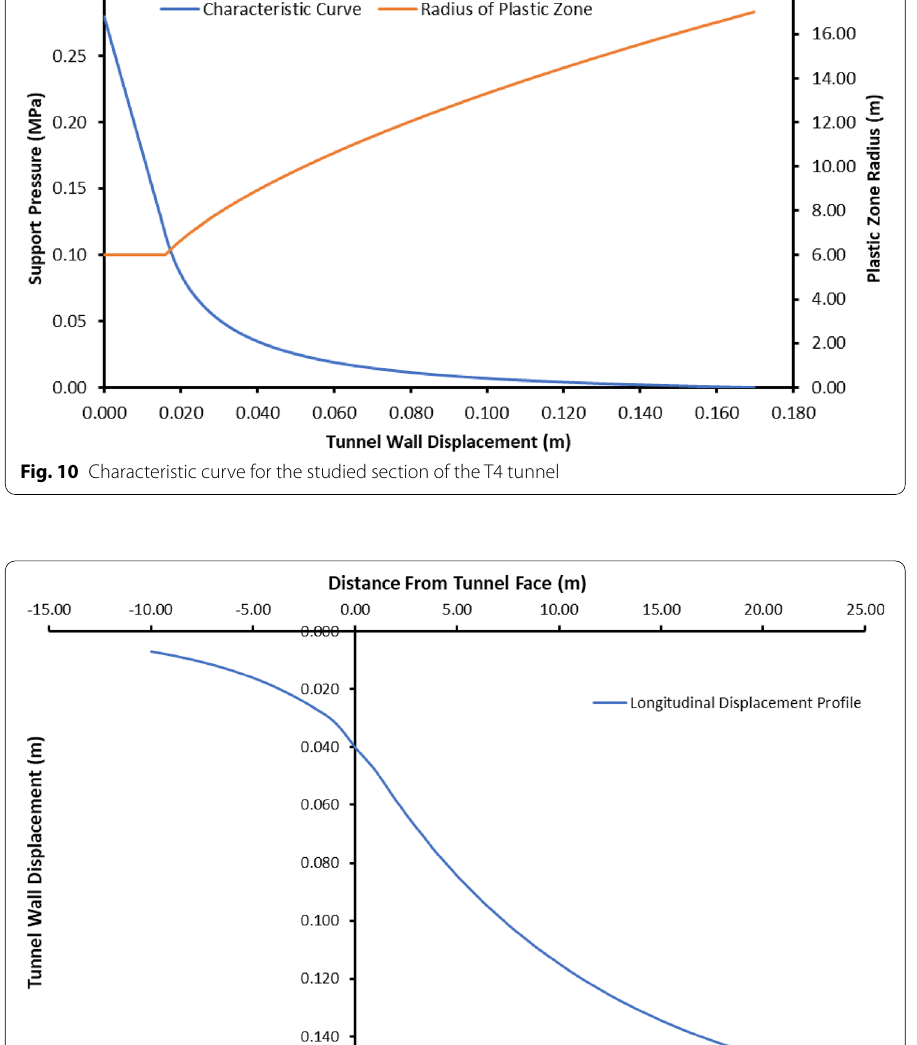
150 employing the relation proposed by Vlachopoulos +